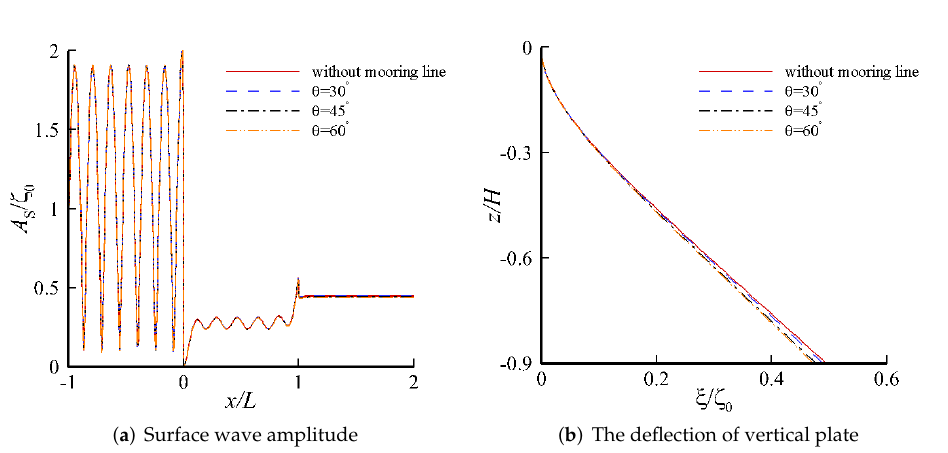
Figure 12. Wave amplitudes A S ( x ) and deflection of vertical plate ξ ( z ) for the different mooring line angle θ